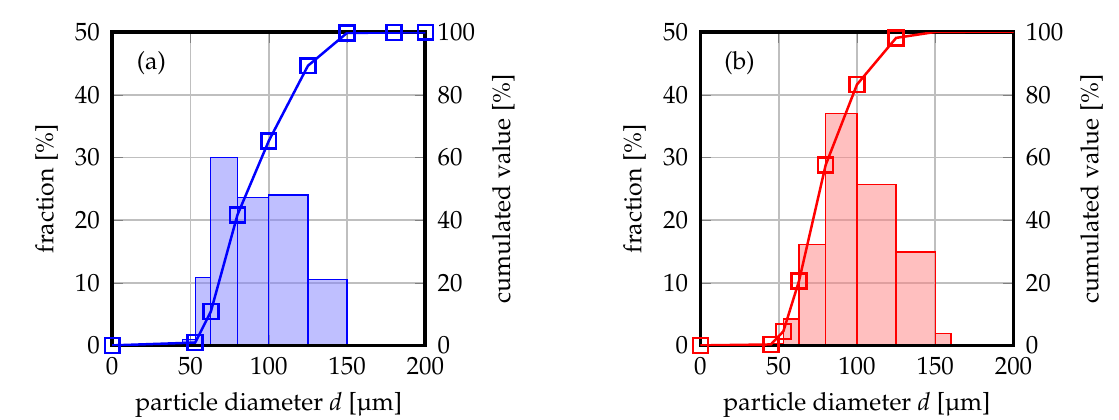
Figure 1. Particle size distribution of ( a ) AISI316L and ( b ) CoCrMo powder material used in the experiments. ( a ) adopted from